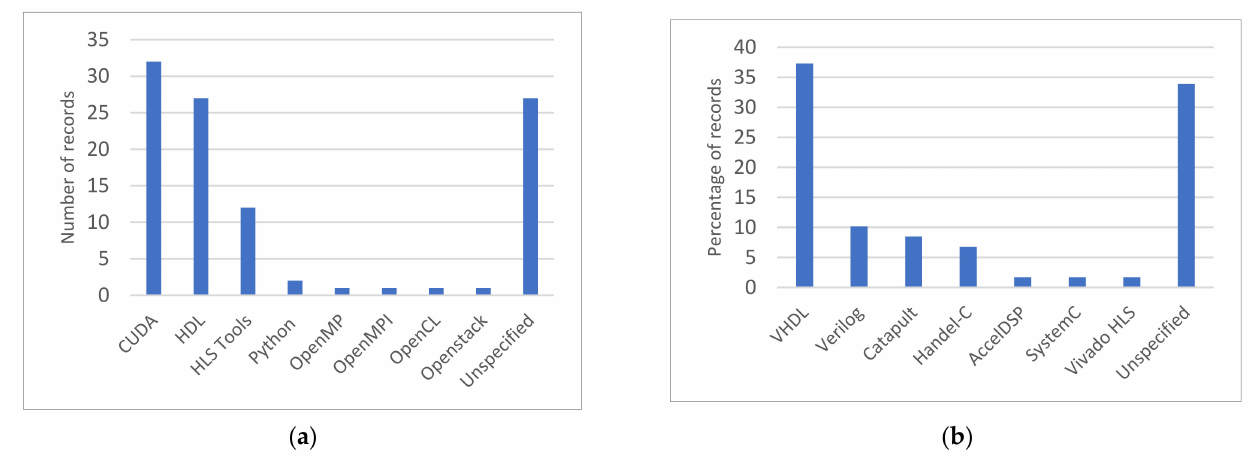
Figure 6. ( a ) Distribution of the collected papers in terms of the programming methods (languages and tools) used for hardware-accelerated compression of HSI; ( b ) Distribution of the records as percentages in terms of the employed programming methods for FPGA-based platforms used in the acceleration of HSI compression.